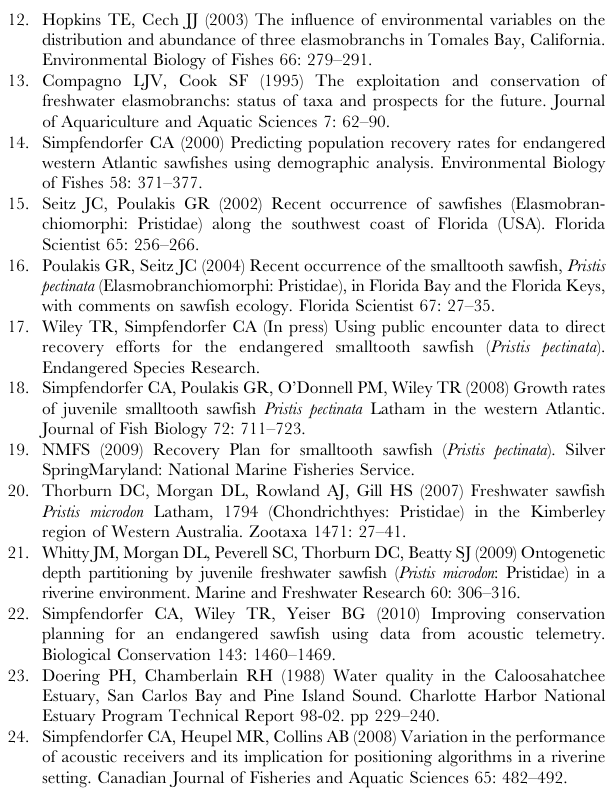
Table S1 Presence and activity space data for